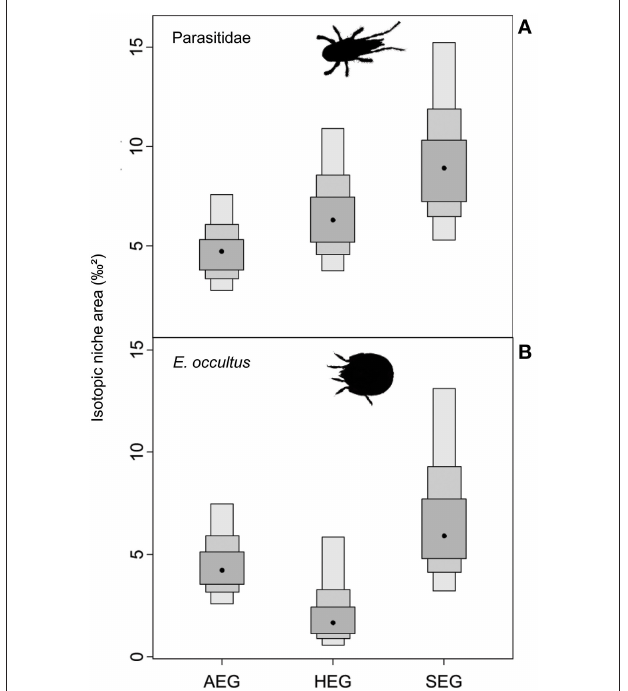
FIGURE 7 | Probability distributions for the size of isotopic niches in different regions from Bayesian standard ellipses with 95, 75, and 50% credible intervals (light to dark gray). Shown are soil arthropod species with differences between at least two regions ( P < 0.05 ). Taxa are (A) Parasitidae and (B) Eupelops occultus (see Table 1 for location and abbreviation of